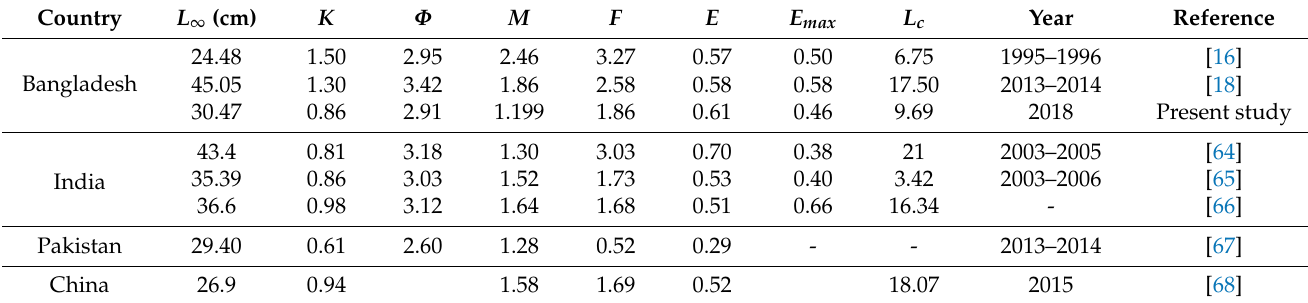
Table 7. Growth parameters, mortality, and exploitation of Bombay duck in different countries in the